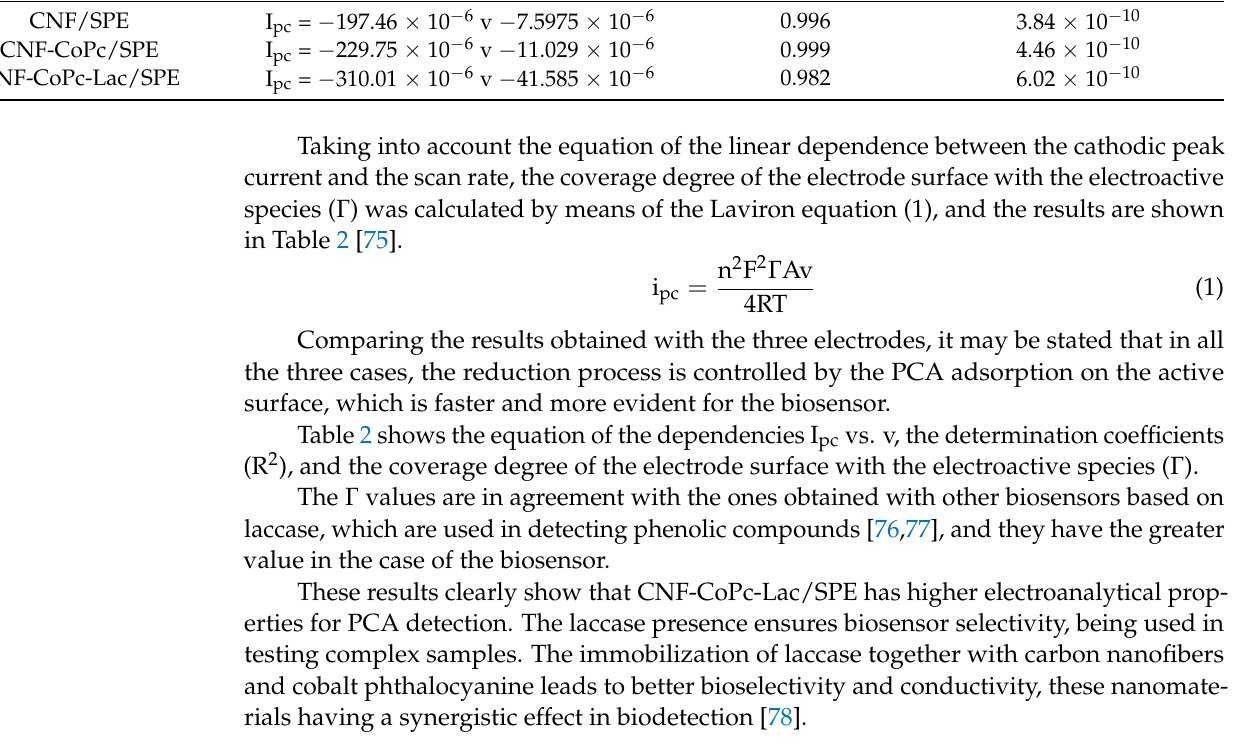
Table 2. The linear fitting equations (I pc vs. v), R 2 , and Γ for the three electrodes used in the analysis.